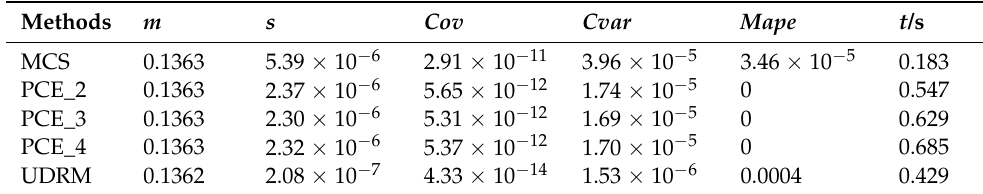
Table 4. Evaluation table of different UQ methods under 50% uncertainty of the grounding resistance under normal operation.